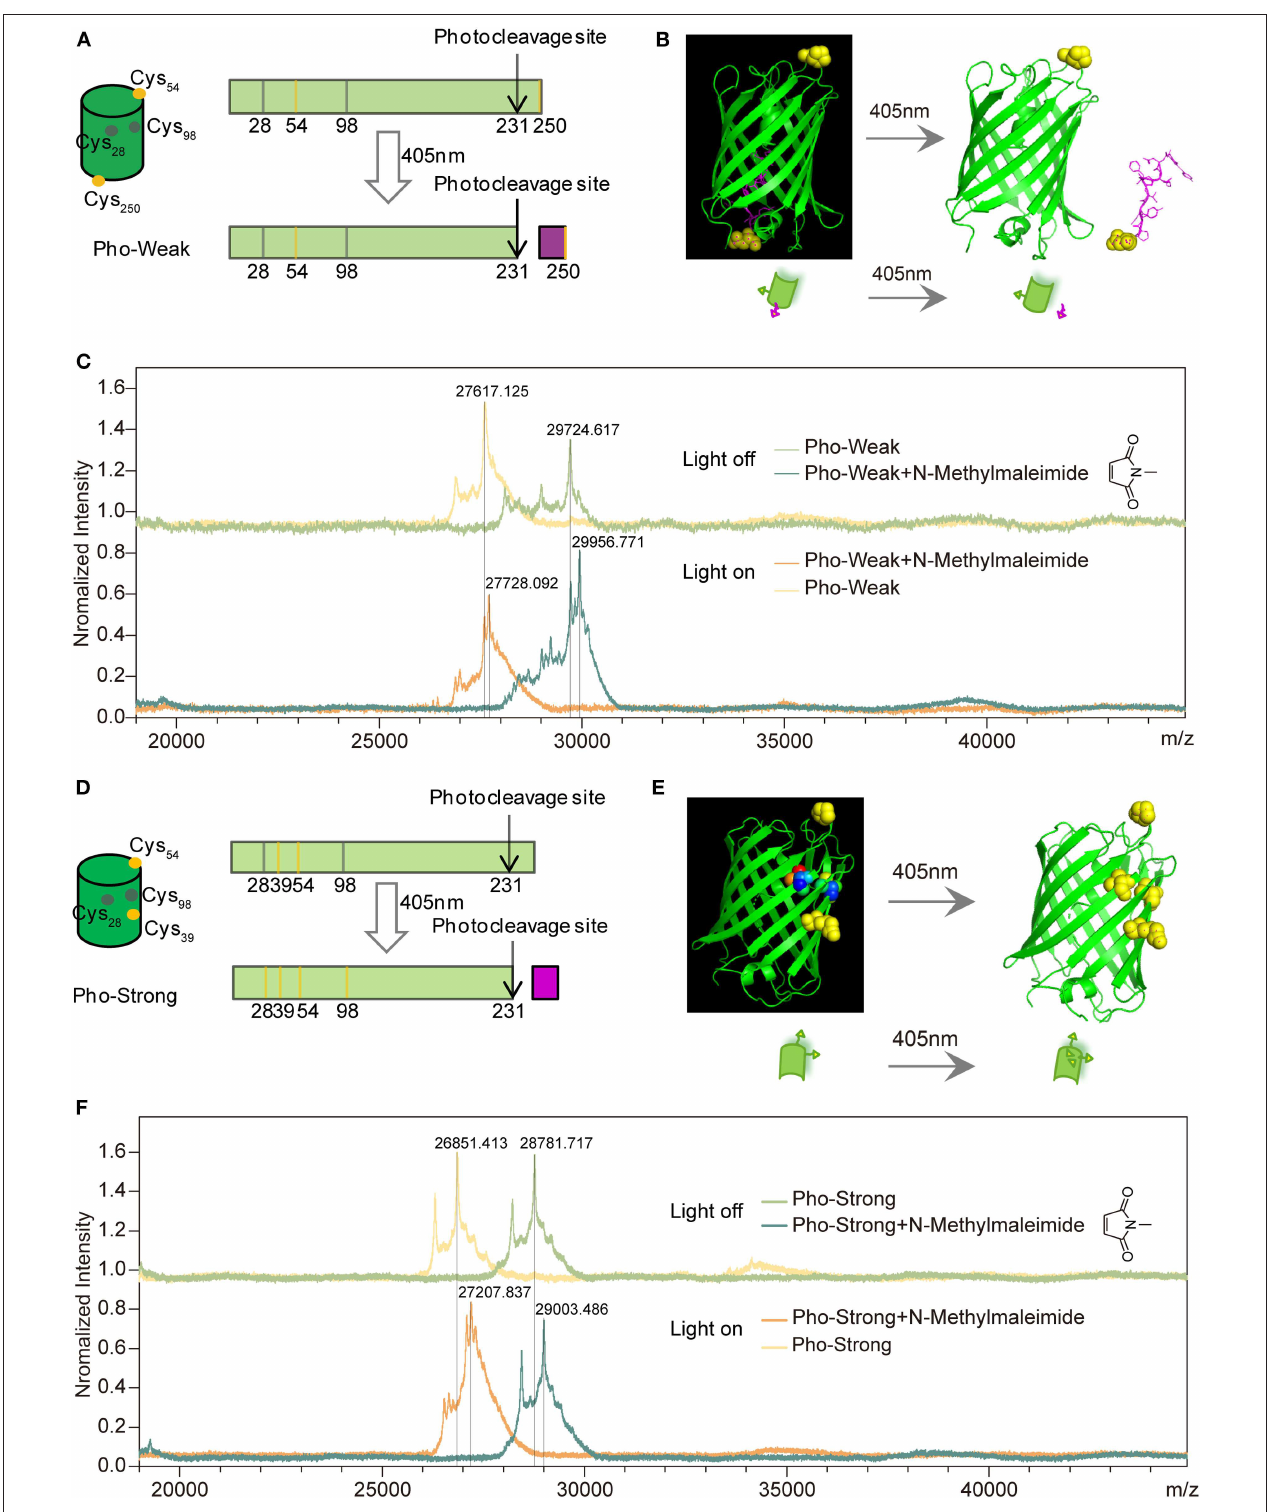
FIGURE 1 | Design of PhoCl mutants. (A) Schematic of the design of Pho-Weak. Two solvent exposed cysteines at 54 and 250 positions (colored in yellow) were introduced to wild type PhoCl for crosslinking with maleimide groups in PEG to form hydrogels. The photocleavage reaction leads to the rupture of the linkage between the two crosslinking sites. (B) Schematic illustration of the dissociation process. (C) MALDI-TOF before and after Pho-Weak photocleavage excited at